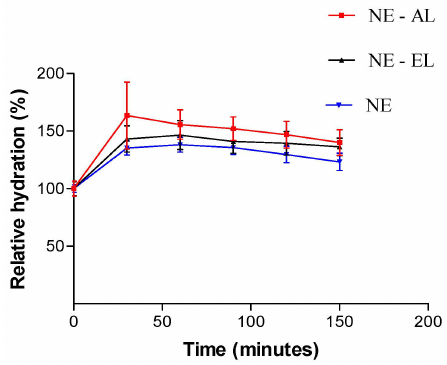
Figure 12. Relative hydration of the stratum corneum in function of time after nanoemulsion application.